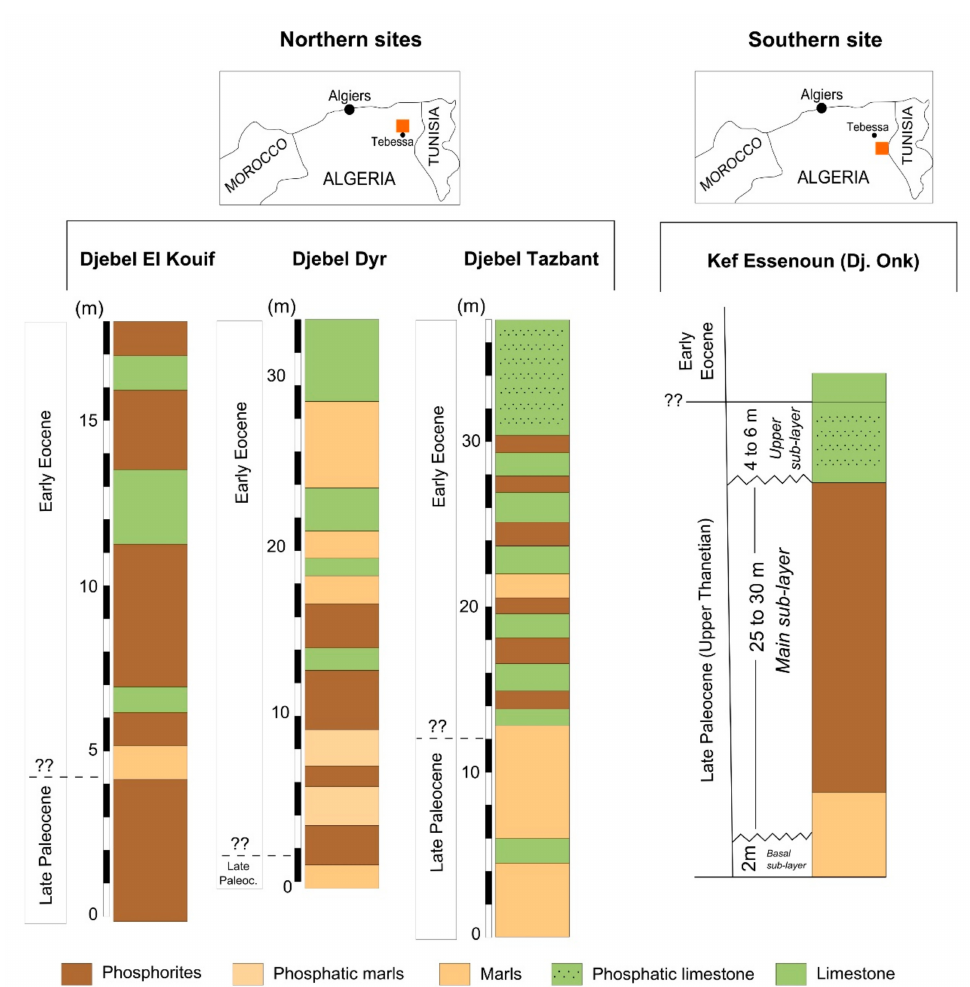
Figure 5. Stratigraphical columns of the phosphorite-bearing sequence from the northern and southern basins of T é bessa region (Algeria). From Kechiched et al.